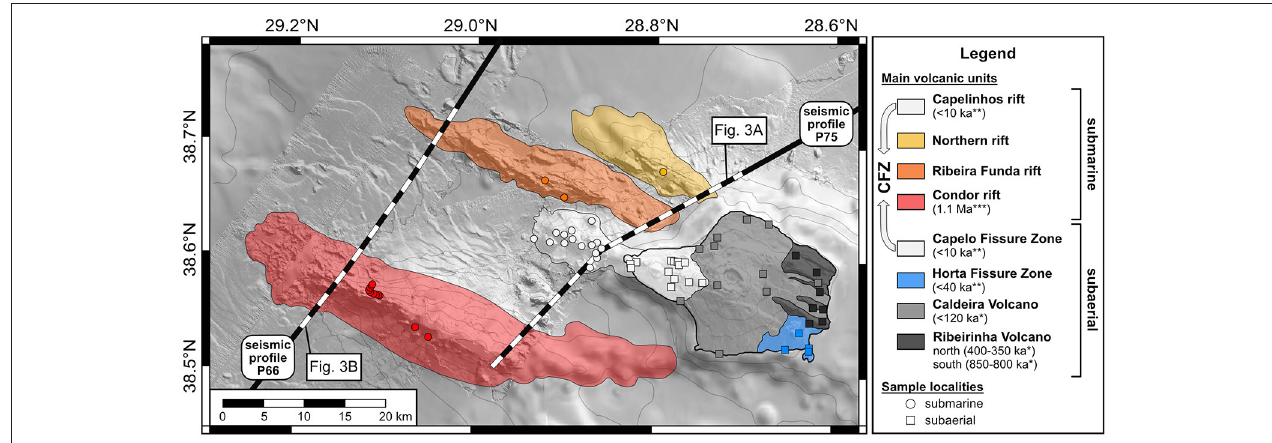
FIGURE 2 | Bathymetric map and DEM of Faial with its neighboring submarine rift zones (same as Figure 1B ). Superimposed areas marked on the island are different volcanic units with distinct periods of volcanic activity based on K-Ar and radiocarbon ages and models from Hildenbrand et al. (2012) (*) and Madeira et al. (1995) (**). The age for Condor rift is based on Ar-Ar dating from Beier et al. (2015) (***). Black lines mark seismic profiles P66 an P75 from cruise M113, highlighted sections are shown in detail in Figure 3 . Symbols mark the locations of lava samples, circles refer to submarine and squares to subaerial samples, respectively. The colors are the same as used in the following diagrams and refer to different volcanic units and their respective ages. (CFZ, Central Fissure Zone; comprising the submarine Capelinhos rift and the subaerial Capelo Fissure Zone).